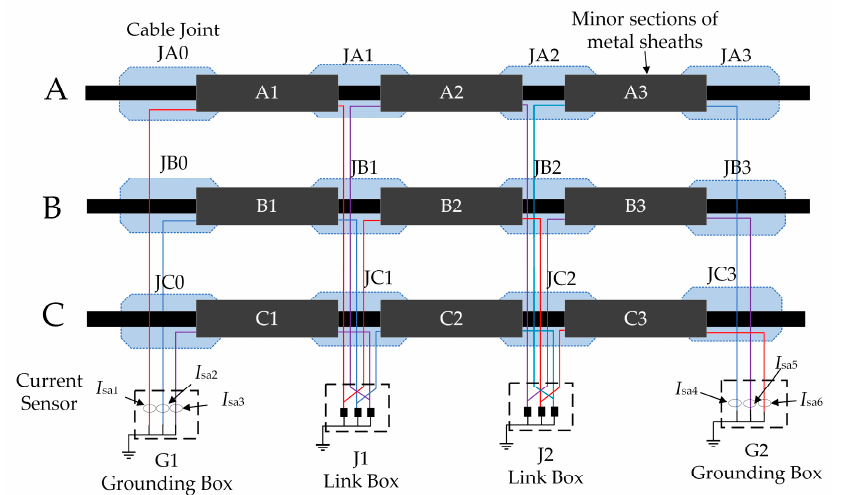
Figure 1. HV cable grounding system model.